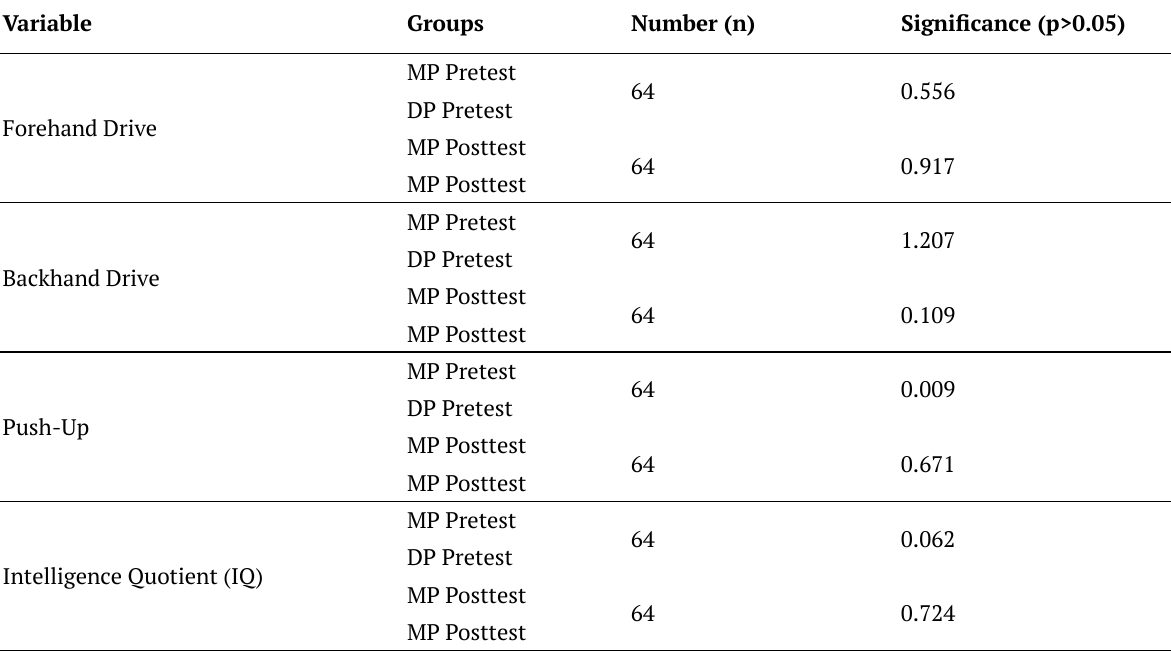
Table 3. The Normality of Forehand, Backhand drive, arm strength, and Intelligence Quotient (IQ) Variable